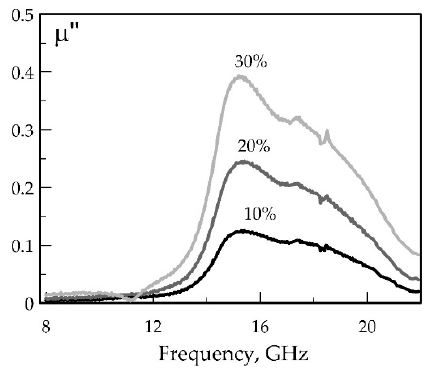
Figure 6. The measured frequency dependence of magnetic loss for the composite samples of BaFe 12 − x Ti x O 19 with different volume fractions of ferrite; x = 1.25.